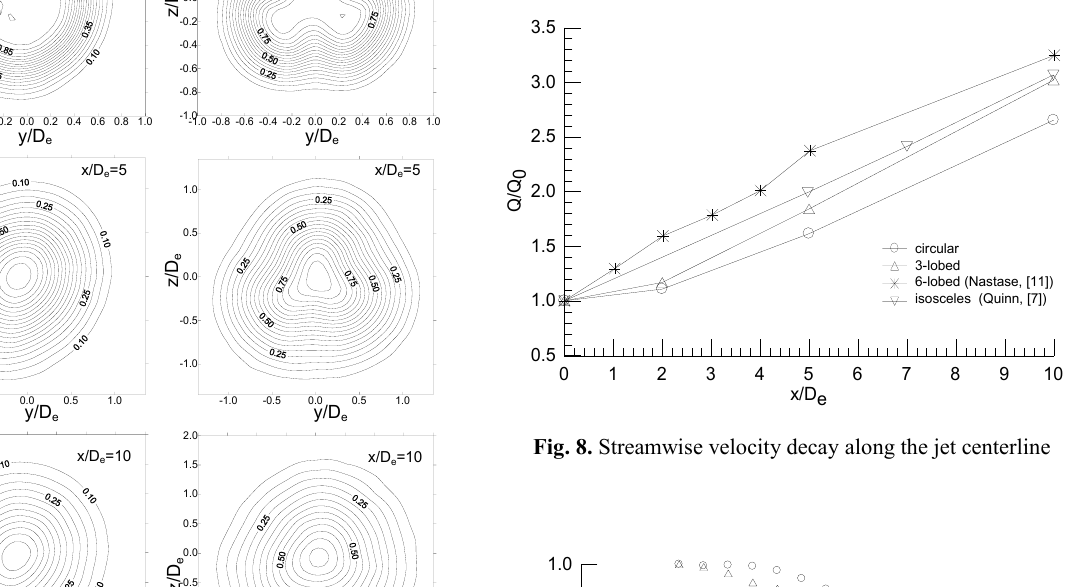
Fig. 7. Reynolds similarity of velocity and turbulence contours